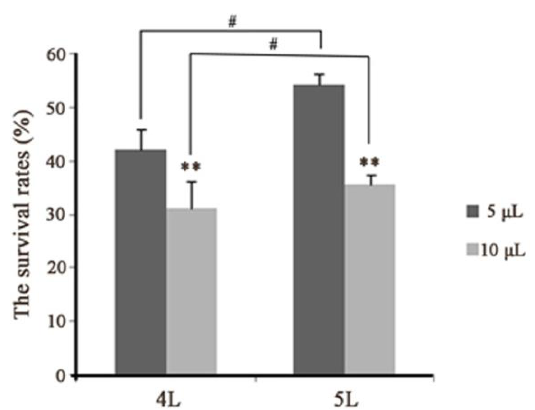
Figure 4. Survival of B. mori -injected E. coli .; 4 L: fourth instar larvae; 5 L: fifth instar larvae. Five and 10 μL represent the doses of E. coli injections. Statistically significant differences are denoted with */# ( p < 0.05), **/## ( p < 0.01) or ***/### ( p < 0.001) for injection in different instar and in one instar, respectively.